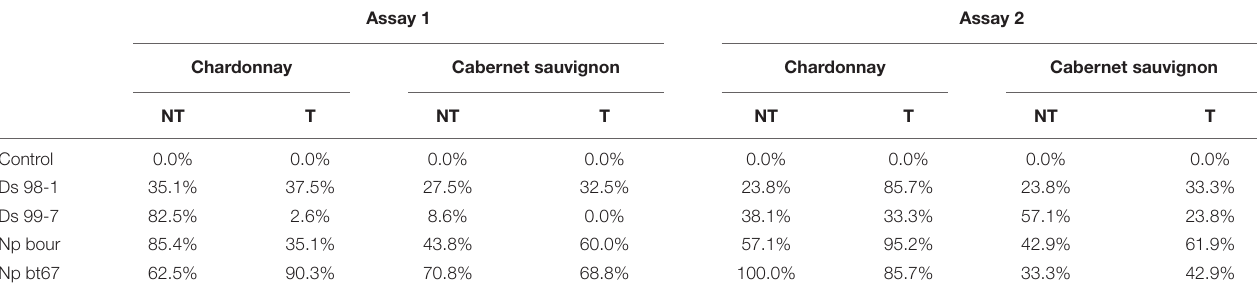
FIGURE 6 | Direct effect of LC2017 on pathogens development in vitro observed at 9 dpi. In (A) , the result of the different concentrations on the colony growth of the four Botryosphaeriaceae used in this study. To same letters correspond no statistical difference. The dotted line represents the initial diameter of mycelial plugs. In (B) , the development of D. seriata strain Ds 98-1 at 4dpi in plates enriched with LC2017 at different concentrations. In (C) , the behavior of Ds 98-1 plugs after 3 days in non-enriched PDA plates: growth recovery from LC2017 at 0.5% (LC2017 fungistatic effect) no growth from LC2017 at 1 and 1.5% (LC2017 fungicide effect). TABLE 7 | Re-isolation percentages of the four Botryosphaeria-dieback pathogens inoculated in vines “Chardonnay” and “Cabernet sauvignon” treated with LC2017 (T) compared to non- treated (NT) in Assay 1 and 2 at 60 dpi. Assay 1 Assay